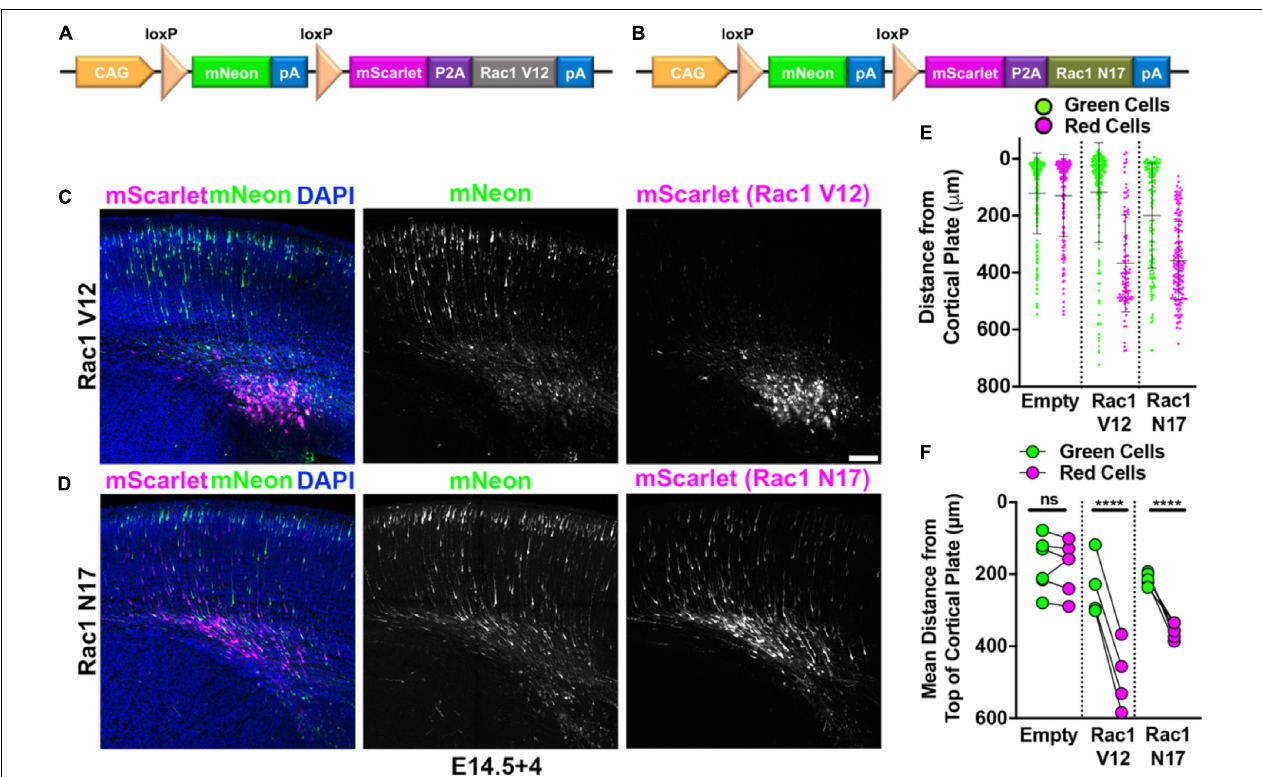
FIGURE 4 | Double UP provides overexpression with an internal control. Robust replication of previously discovered migration defects utilizing Double UP. (A) Schematic of Double UP Rac1-V12. (B) Schematic of Double UP Rac1-N17. (C) Representative image of Double UP Rac1-V12, E14.5+4. Scale bar, 100 µ m. (D) Representative image of Double UP Rac1-N17 E14.5+4. (E) Dot plot of three representative slices from Double UP, Double UP Rac1-V12, and Double UP Rac1-N17. Each dot represents distance from the top of the cortical plate to the center of mass for each neuron. (F) Dot plot of Double UP, Double UP Rac1-V12, and Double UP Rac1-N17 ( n = 6, 4, and 5 slices, respectively, each from a different brain). Each dot represents mean distance from the top of the cortical plate to the distance of all cortical neurons in a slice. Connected dots indicate measurements were made in the same brain. ns = not significant, **** p < 0.0001, two-way ANOVA. Error bars not shown for clarity. See also Supplementary Figure S2